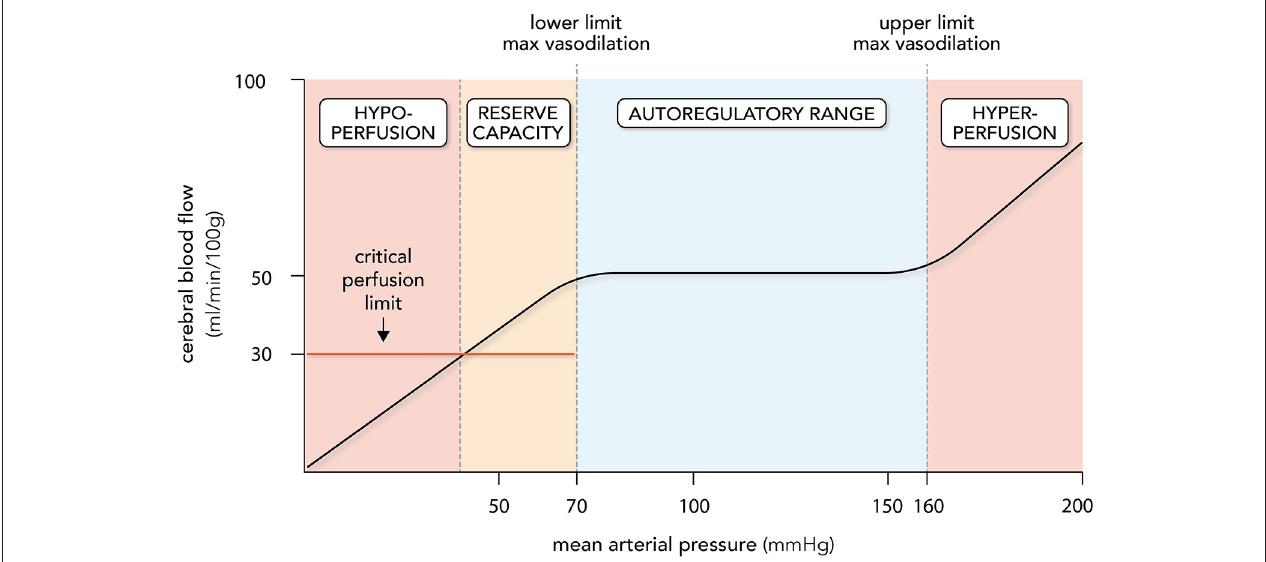
FIGURE 1 | Cerebral autoregulation. Cerebral autoregulation is plotted as a relationship between cerebral blood flow (CBF) and mean arterial pressure (MAP). The autoregulatory range is defined by MAP levels that elicit maximal myogenic vasodilation (lower limit; ∼ 70 mmHg) and myogenic vasoconstriction (upper limit; ∼ 160 mmHg): CBF remains relatively stable as MAP changes within this range. Perfusion decreases when MAP drops below the lower limit; however, overt symptoms are not observed until a critical perfusion threshold is reached, usually 40–60% below normal levels. The MAP range where perfusion drops without symptoms is termed the cerebrovascular reserve capacity. Hypoperfusion and ischemia occur at MAP levels below the reserve capacity; hyperperfusion and vasogenic edema occur at MAP levels above the upper limit. It must be stressed that the lower and upper limits of autoregulation, the size of the cerebrovascular reserve capacity and the level of perfusion maintained by autoregulation all display variation. Thus, the plot represents regularly quoted